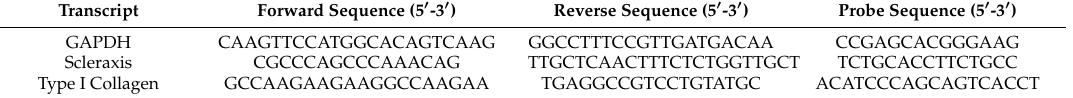
Table 1. Primer and probe sequences of tendon-associated genes for qPCR analysis.